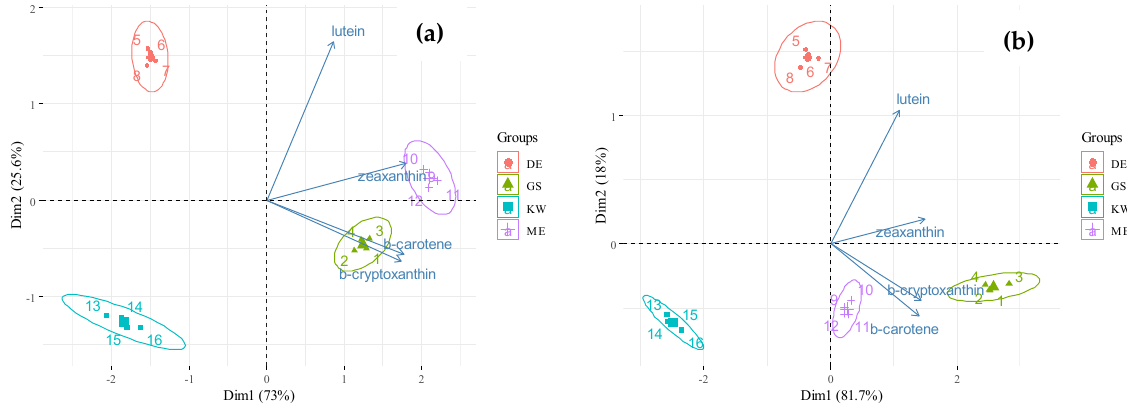
Figure 9. Concentration ( a ) and yield of lutein, zeaxanthin, β -cryptoxanthin, β -carothene ( b ).